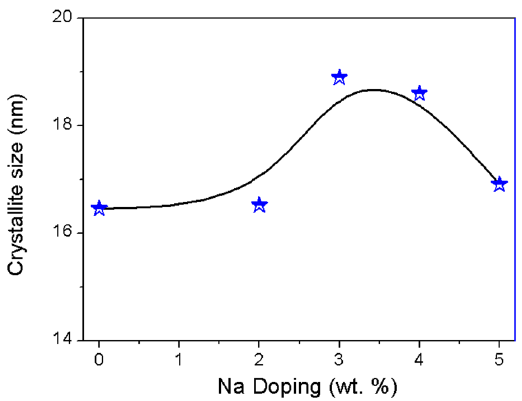
Figure 3. The variation of crystallite size of (111) peak in Na doped NiO thin films at different doping levels.